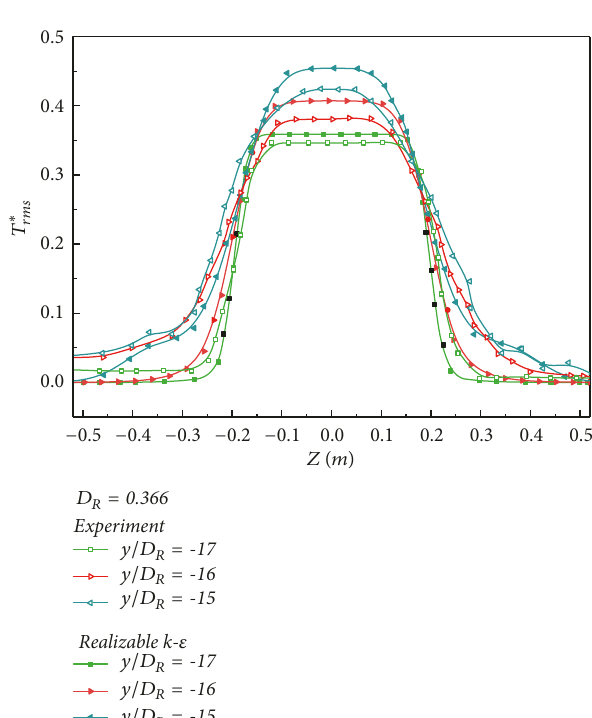
Figure 8: Comparison of dimensionless RMS temperaturebetween numerical data and experimental